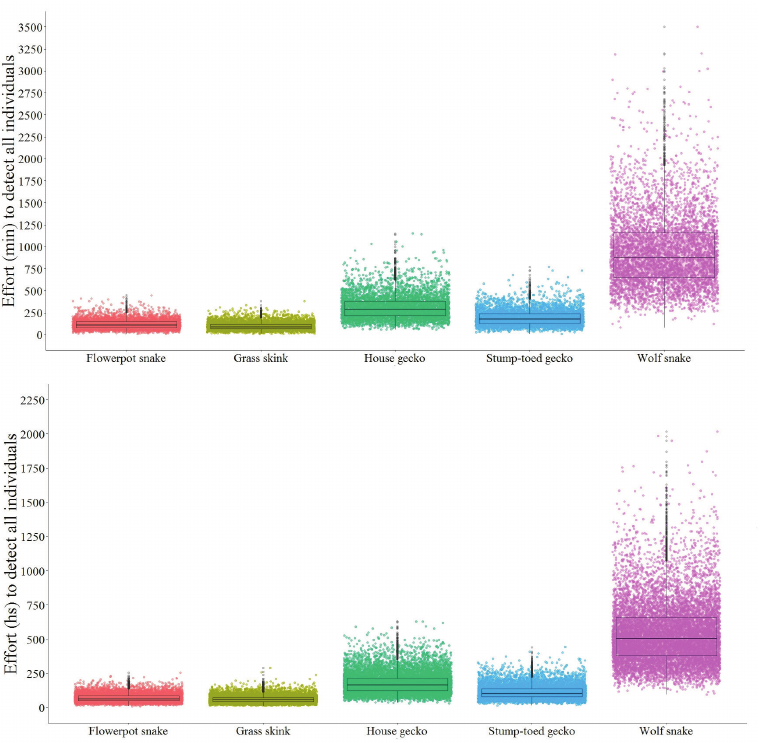
Figure 3. Estimated surveying effort required to detect all 10 individuals of each species of five alien reptiles in two situations and under a best-case detection scenario (i.e., sites surveyed during the time of the day when detection probabilities are higher). Top: surveying effort (minutes) to detect 10 individuals known to be present in one surveying site when only those 10 individuals are present; bottom: surveying effort (hours) to detect 10 individuals distributed at random across 34 surveying sites, where each occupied site harbours one individual, and only ten individuals are present across the 34 surveying sites. We used 10 individuals as an example to showcase and compare detection efforts across different situations. Best-case detection scenarios are night time surveys (common house gecko, stump-toed gecko, and flowerpot snake) and daytime surveys (grass skink and wolf snake). Each dot represents a realisation from 1000